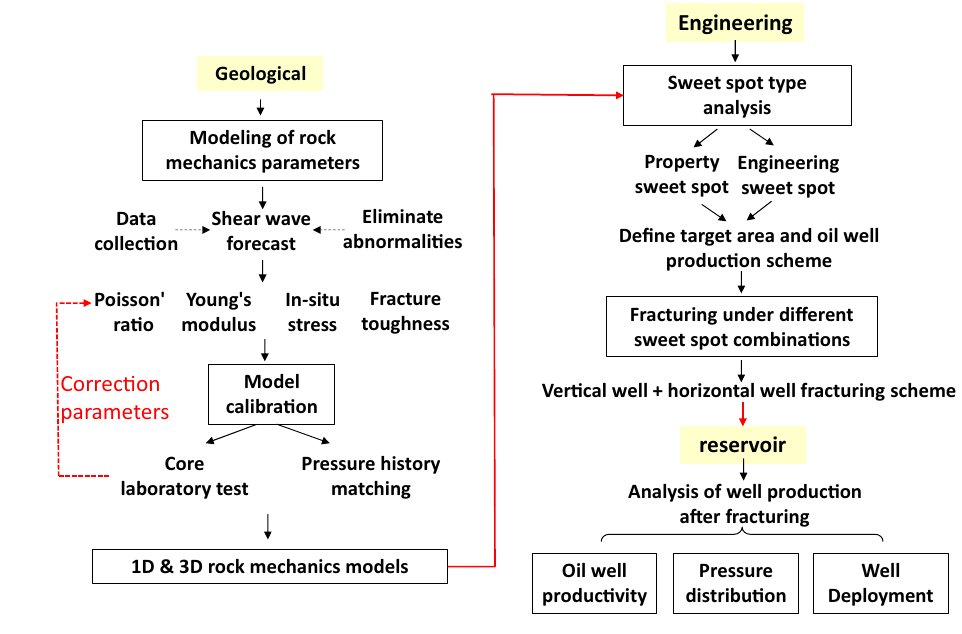
Fig. 3 Complete implementa- tion diagram of the integrated process of geology, engineering, and reservoir simulation